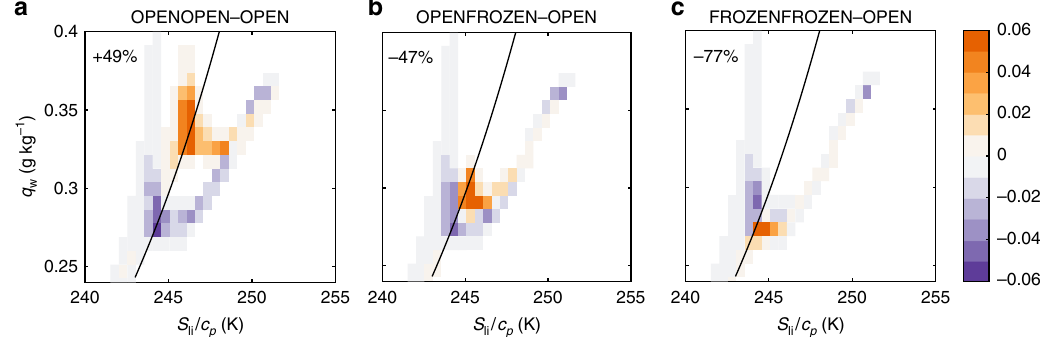
Fig. 6 Mixing diagram of the difference between high and low lead fraction cases. a Differences of PDFs of thermodynamic state characterized by liquid- ice static energy ( S li ∕ c p ) and total water mixing ratio ( q w , sum of the water vapor, cloud water, and cloud ice) between OPENOPEN and OPEN. Plotted results are from the last two simulation hours for all model grid volumes within a selected domain with x extending from 20 to 30 km and z extending from the bottom level to 300 m, where most clouds occur. The solid black line indicates the theoretical cloudy-clear boundary line, with cloud ice mixing ratio equal to 0.01 g kg − 1 . b The same as a but for differences between OPENFROZEN and OPEN case PDFs. c The same as a but for differences between FROZENFROZEN and OPEN case PDFs. In the OPEN case, x extends from 10 to 20 km. The percentages on the top left are the percentage changes of cloudy volume fraction from the OPEN case to the other three Supplementary Fig. 7. Results are from a 10 km by 12.8 km by Fig. 8) and water vapor fl ux (Supplementary Fig. 10) over the two 300 m domain with grid volumes of 200 m by 200 m by 12 m. We open leads in the OPENOPEN case. However, the fraction of sampled the simulation results every 5 min, and calculated the cloudy grid volumes decreases by 47% from OPEN to OPEN- PDF of each thermodynamic state bin for the last two hours. The FROZEN. While a large number of grid volumes shift to a higher PDF difference indicates an ~49% increase in the cloud volume liquid-ice static energy, increases in total water mixing ratio are fraction from the OPEN to OPENOPEN cases (Fig. 6a), owing to not suf fi cient to maintain all of the previously cloudy grid the shift of a large number of grid volumes to a larger total water volumes (Fig. 6b). The reduced water vapor supply (Supplemen- mixing ratio and larger liquid-ice static energy from below to tary Figs. 10, 11) as well as the relatively large temperature fl ux above the cloudy-clear boundary (black curve). This is caused by (Supplementary Figs. 8, 9) over the frozen lead, which provides the large vertical turbulent temperature fl ux (Supplementary the necessary buoyancy for convection and entrainment of warm